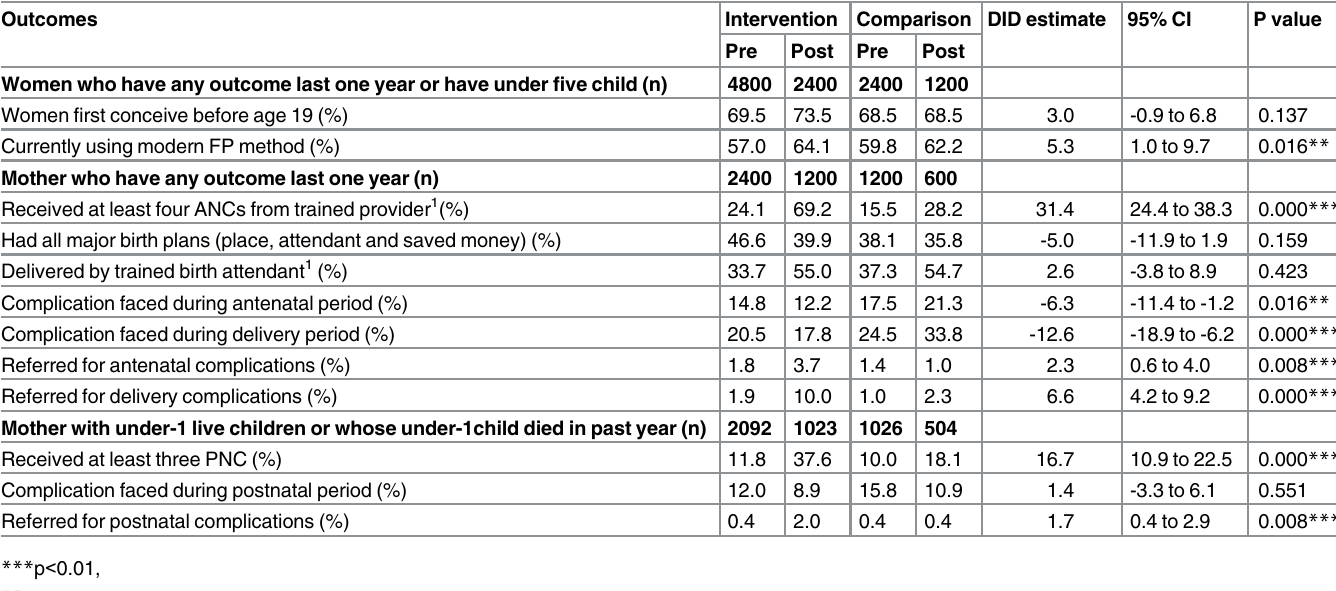
Table 3. DID analysis of the impact of the IMNCS intervention on maternal health indicators. Outcomes